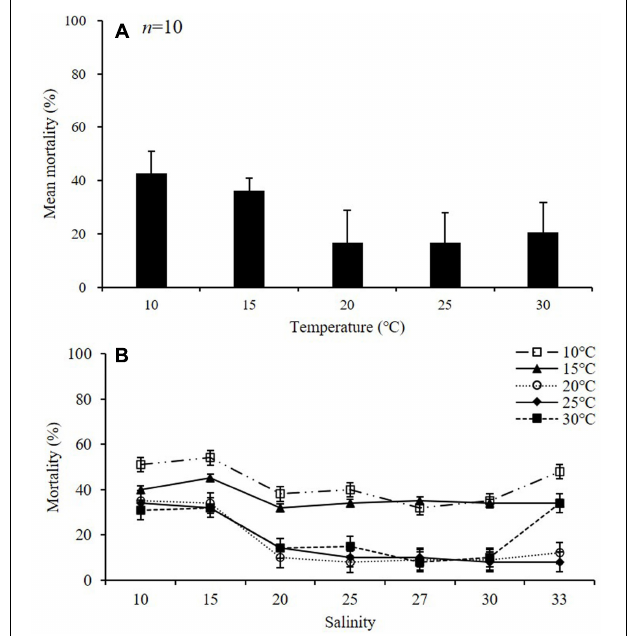
FIGURE 4 | Mortality of adult female Acartia ohtsukai . Mean mortality at each temperature (A) and mortality at each temperature and salinity (B) are shown. Data are presented as mean ± standard error (SE). Different letters above the bars indicate significant differences ( p < 0.05).